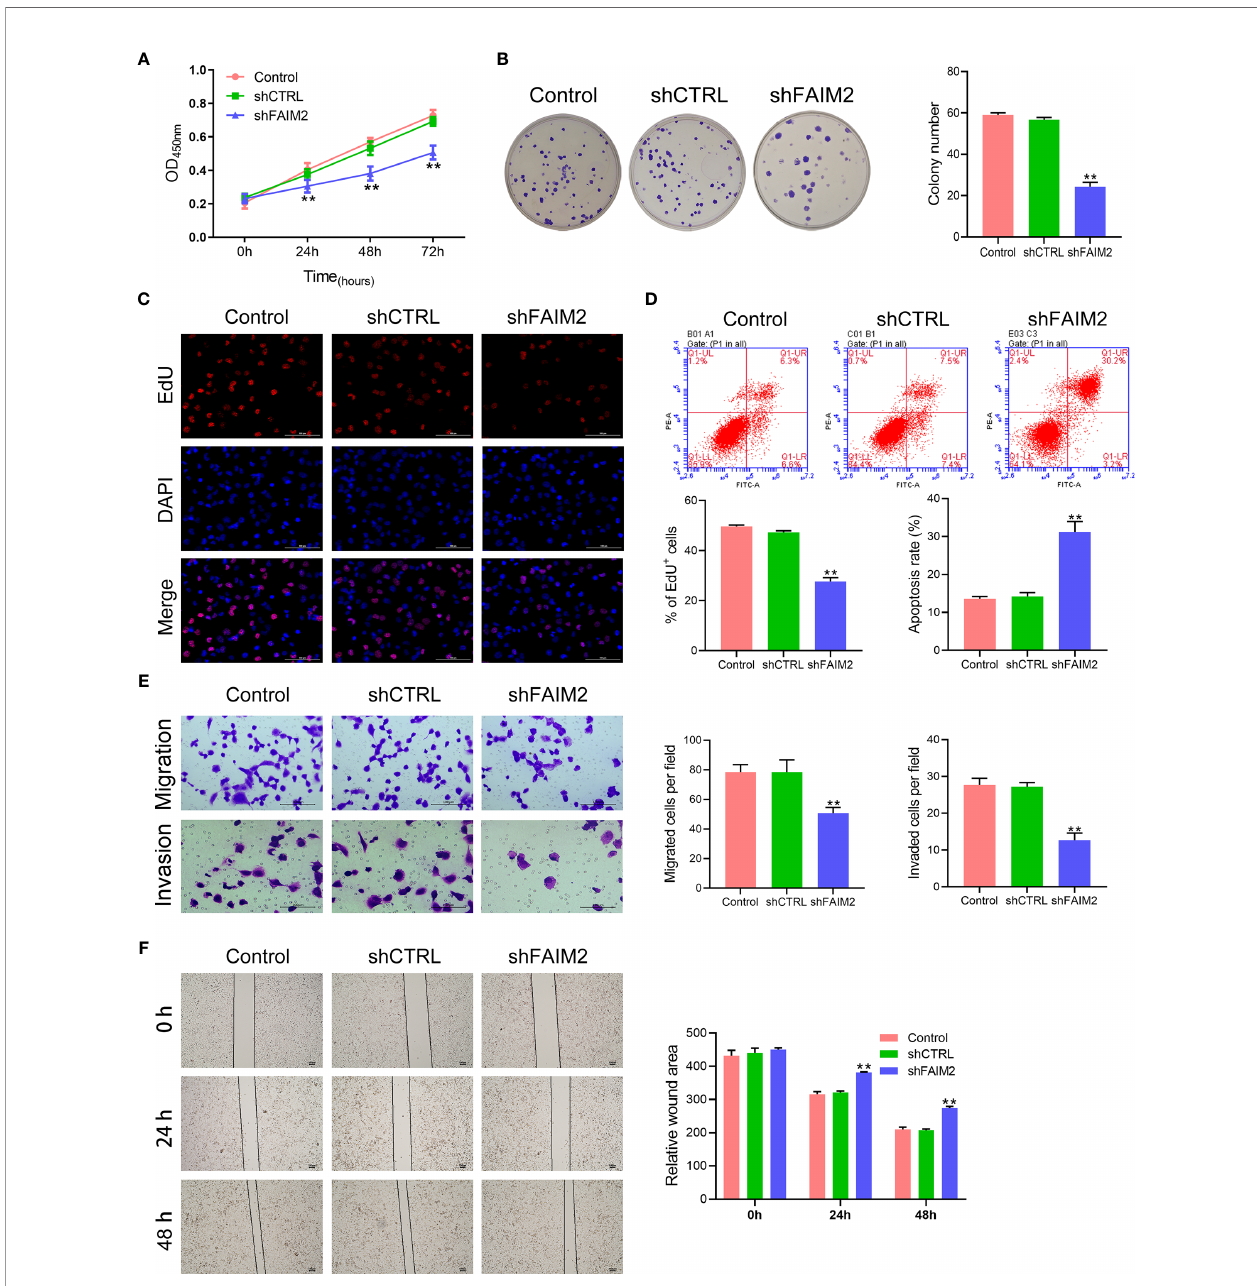
FIGURE 4 | Downregulation of FAIM2 reduced HARA-B4 cell proliferation, migration, and invasion, but promoted cell apoptosis. Following shCTRL or shFAIM2 transfection, (A) the viability of HARA-B4 cells was detected via the CCK-8 assay. (B, C) HARA-B4 cell proliferation was evaluated via the colony formation assay and EdU staining. (D) HARA-B4 cell apoptosis was assessed by fl ow cytometry. (E) HARA-B4 cell migration and invasion were measured via the two-chamber Transwell assay. (F) The cell scratch assay was conducted to further test for HARA-B4 cell migration. P < 0.01, ** vs. the shCTRL